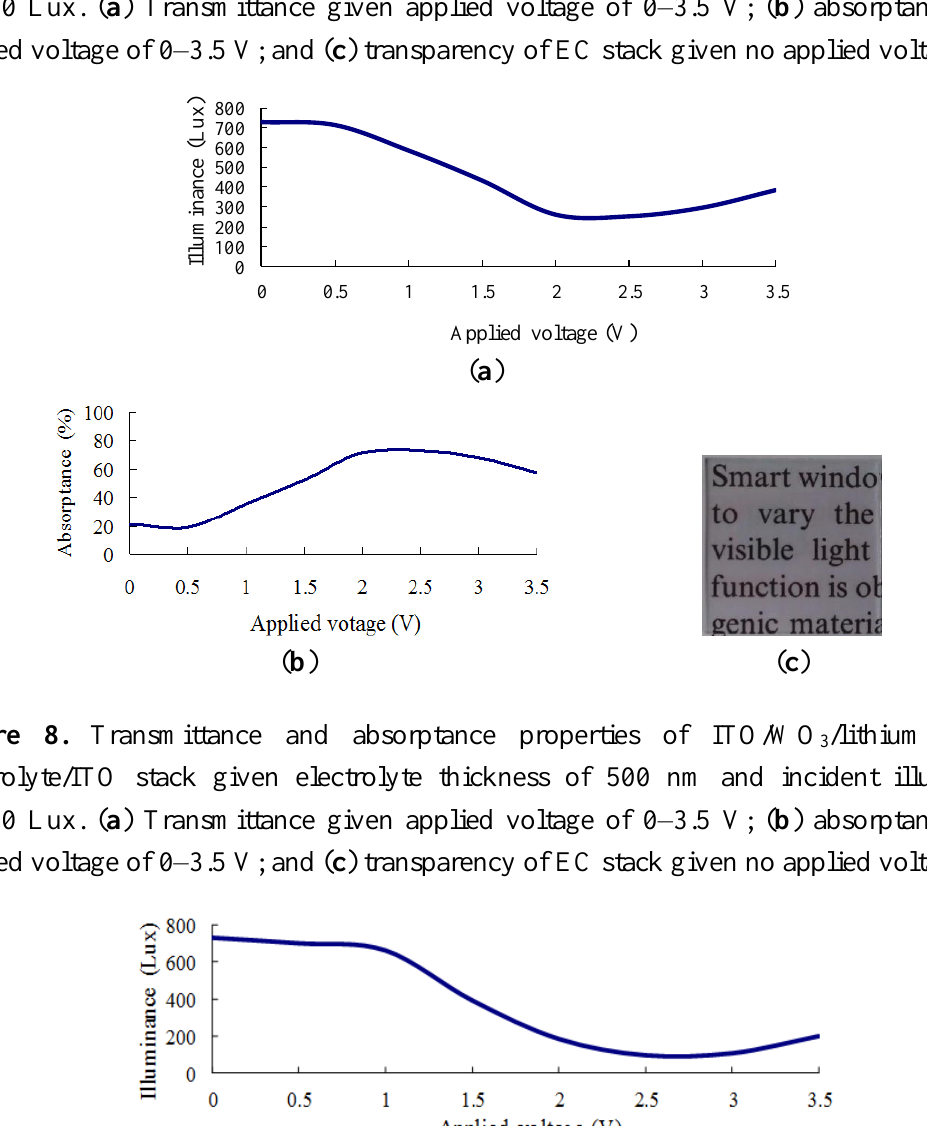
/lithium-polymer 3